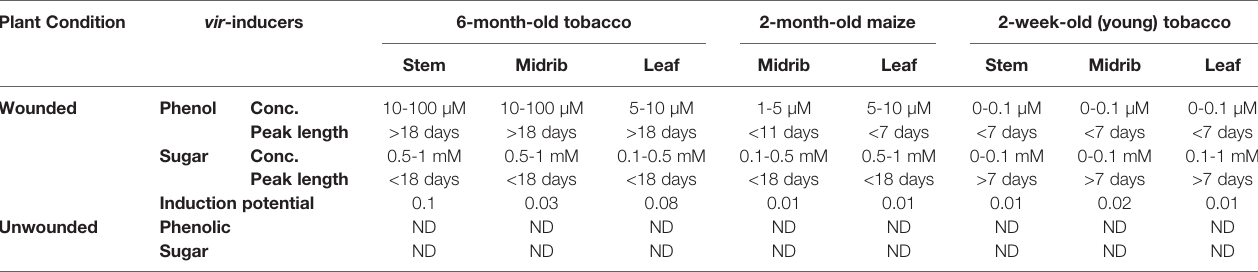
TABLE 4 | Summary of the quanti fi ed phenolic, sugar, or combined effect of both inducers, released from tobacco and maize as conditioned by wounding, organ/ tissue types, or age. Plant Condition